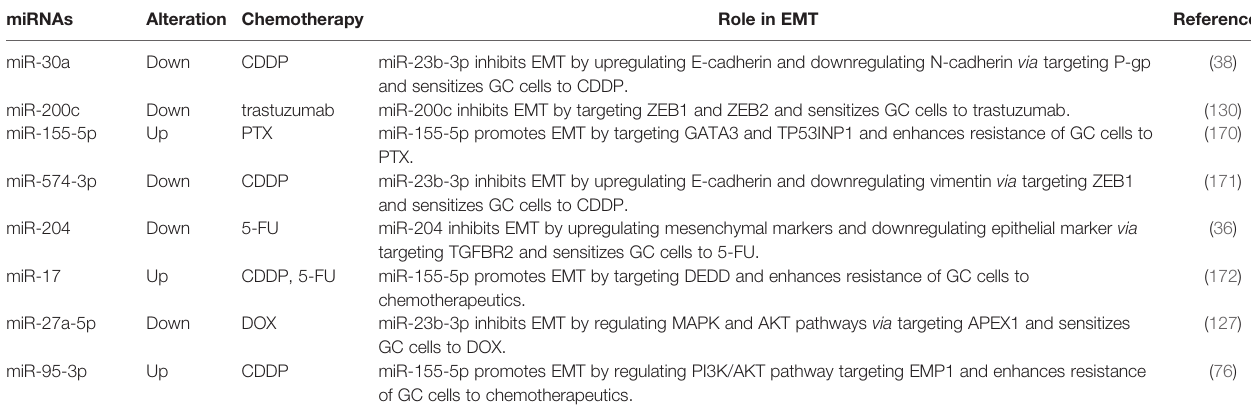
TABLE 3 | The role of miRNA-mediated EMT in GC drug resistance. miRNAs Alteration